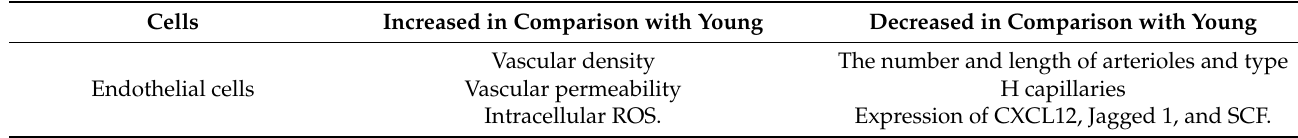
Table 4. Aging-related changes in the mouse BM niche, adapted from [74]. Cells Increased in Comparison with Young Decreased in Comparison with Young Vascular density The number and length of arterioles and type Endothelial cells Vascular permeability H capillaries Intracellular ROS. Expression of CXCL12, Jagged 1, and